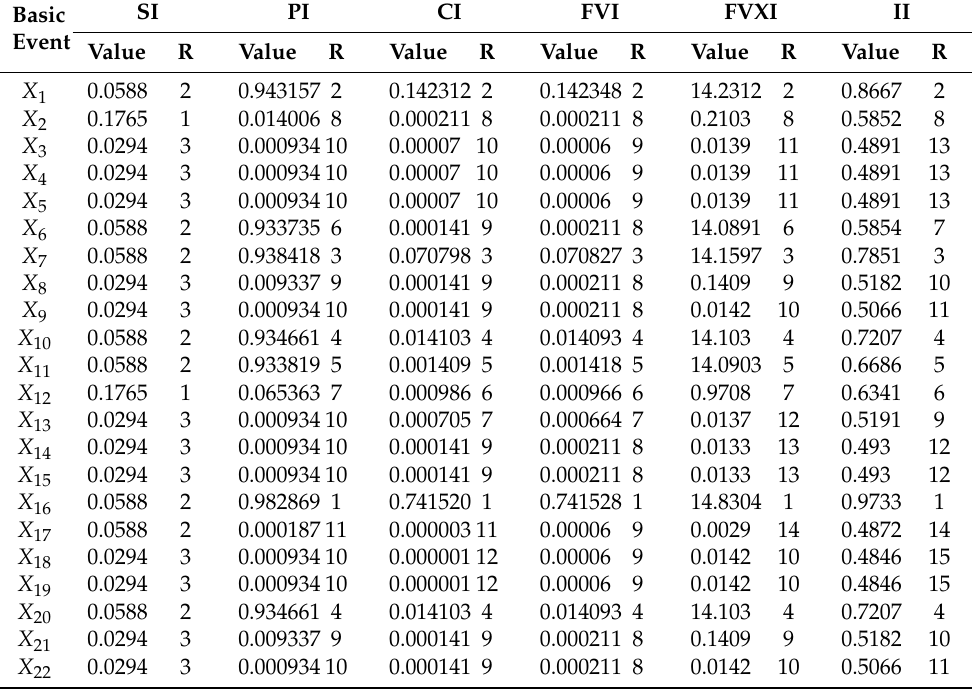
Table 2. Importance of basic events of hydraulic support